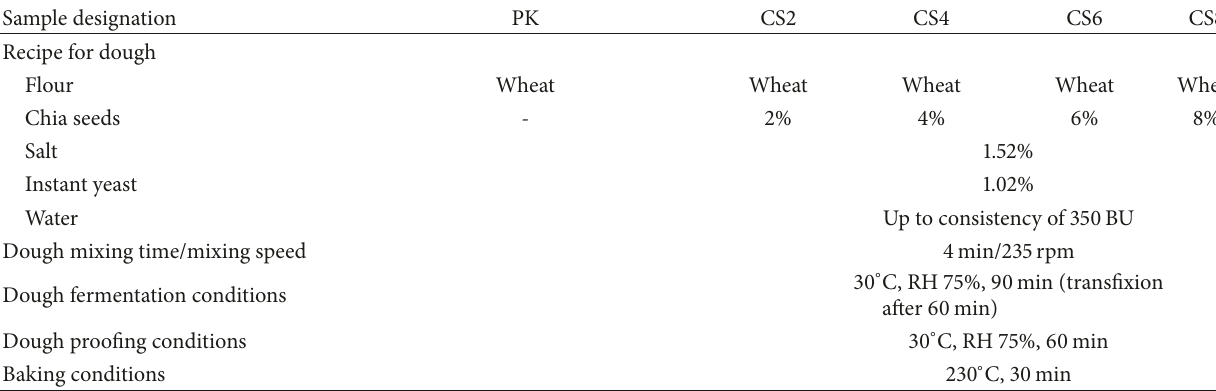
Table 1: Bread making